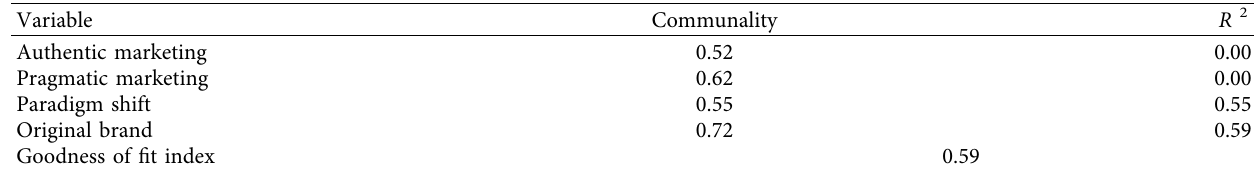
Table 5: Calculation of internal model fitting (first-order analysis).